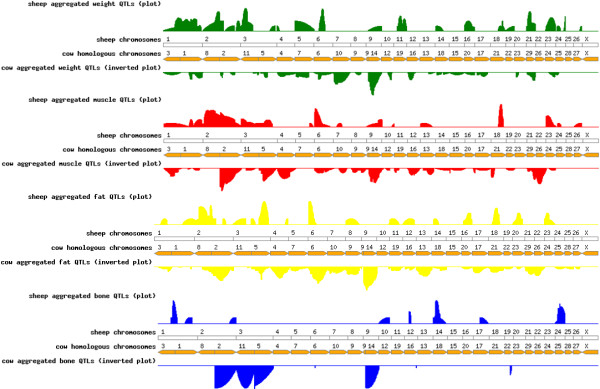
Comparative genome map of aggregated meta-scores for carcass-related QTL derived from sheep and cattle studies.